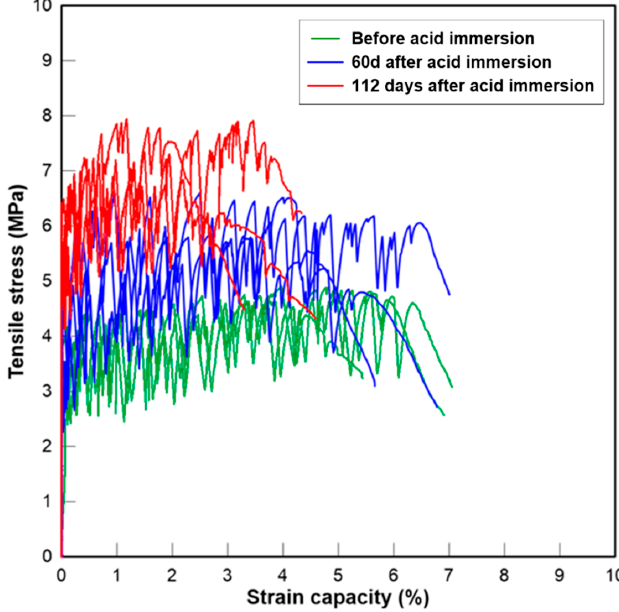
Figure 10. Tensile stress-strain curves of CAC-GGBFS 1.5PE.